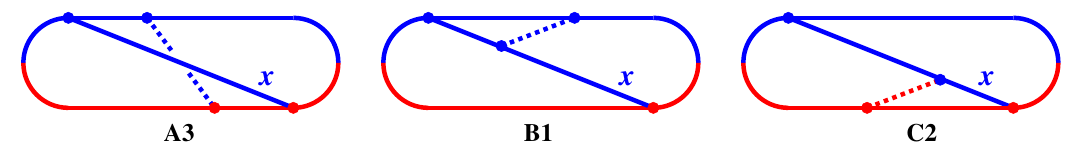
Figure 7 . Three examples of figure 6. The soft y gluon is denoted by the dashed line. A3 and C2 contribute to the rate for double splitting g → ggg , whereas B1 is an example of a virtual (i.e. loop) correction to single splitting g → gg . In the nomenclature of ref. [20], A3 is called xy ¯ y ¯ x , B1 is yxy ¯ x with renaming y ↔ z ≡ 1 − x − y of the loop momentum fraction variable, and C2 is z ¯ yy ¯ z (the x ↔ z permutation of x ¯ yy ¯ x